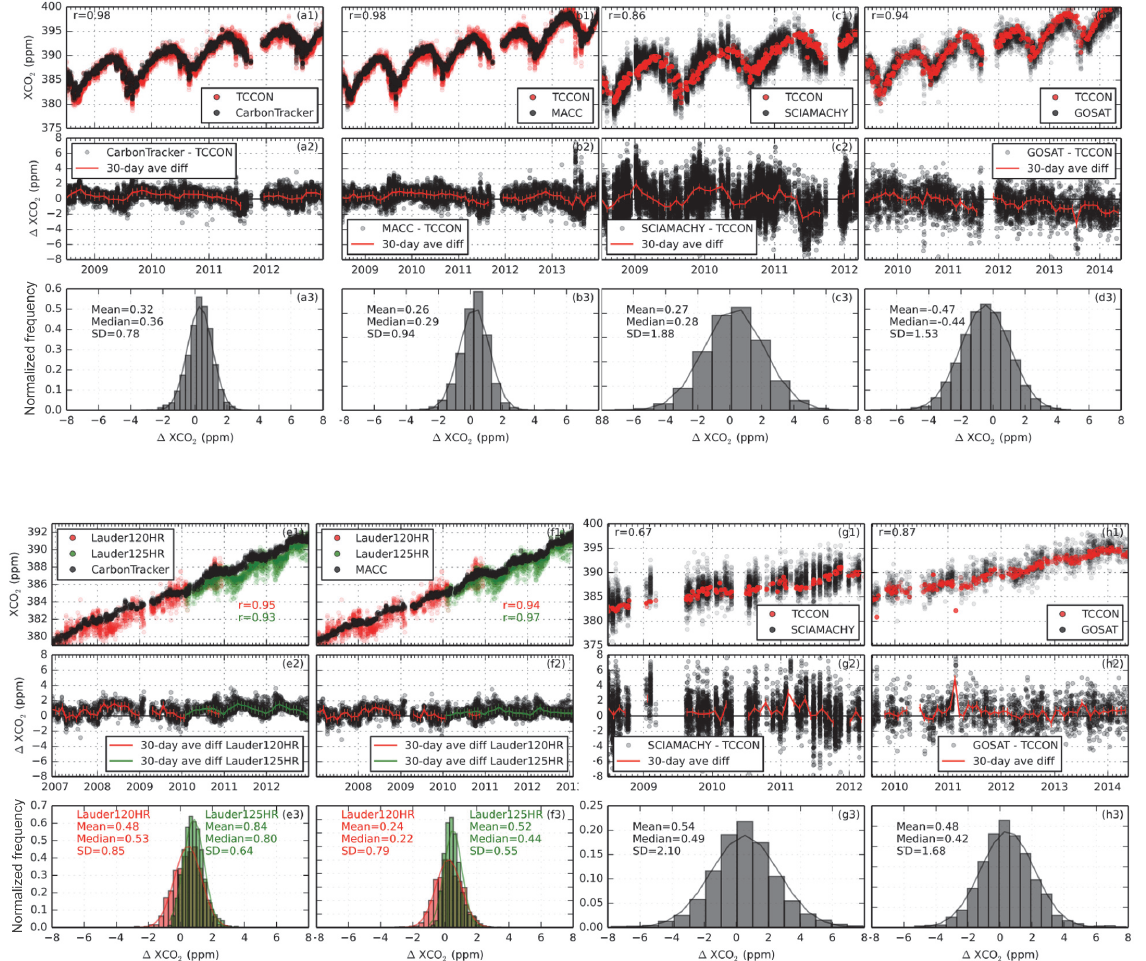
Figure 2. Time series for matches of CT2013b, MACC, SCIAMACHY, and GOSAT vs. TCCON at Lamont (a–d) and Lauder (for models) or Wollongong (for satellites) (e–h) . The top plot of each set (a1, b1, c1, ...) shows a time series of all geometric matching pairs. The middle panel of each set (a2, b2, c2, ...) shows the difference vs. TCCON, with the blue line denoting the 30-day average difference. The bottom panel of each set (a3, b3, c3, ...) shows a histogram of the differences, indicating an approximate error and